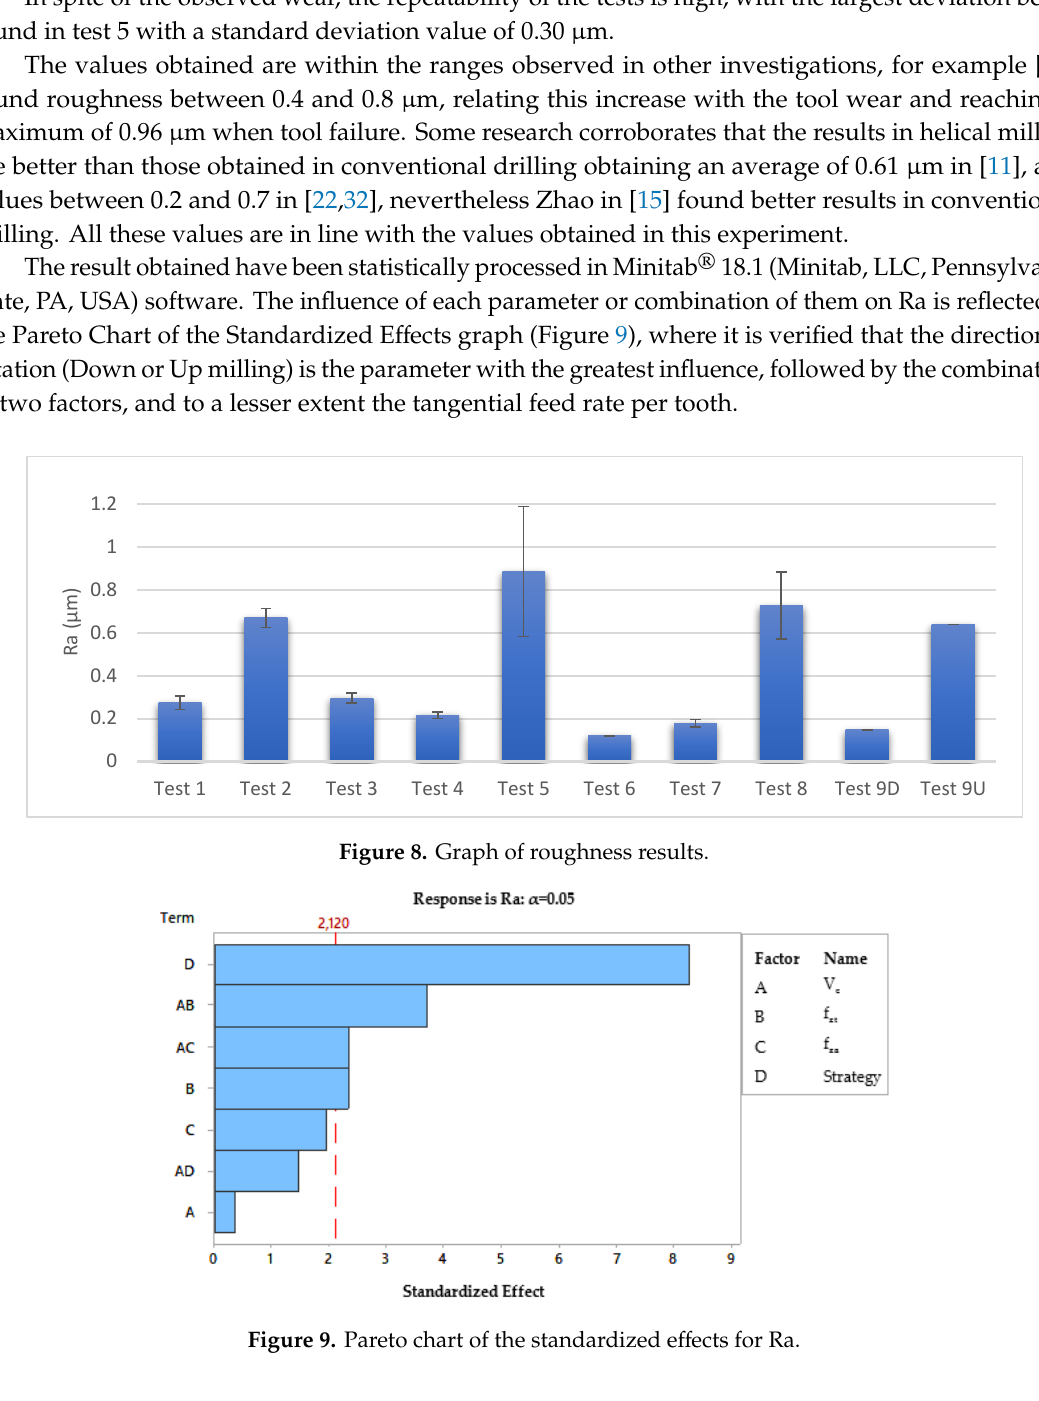
Figure 9. Pareto chart of the standardized effects for Ra.